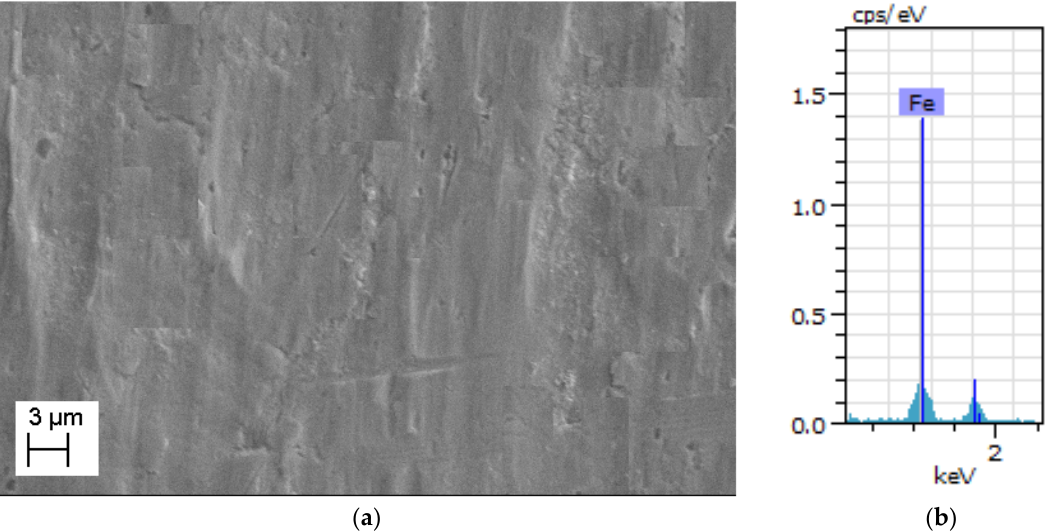
Figure 7. ( a ) SEM image of hydrogen-annealed pure iron. ( b ) EDS analysis of hydrogen-annealed pure iron.